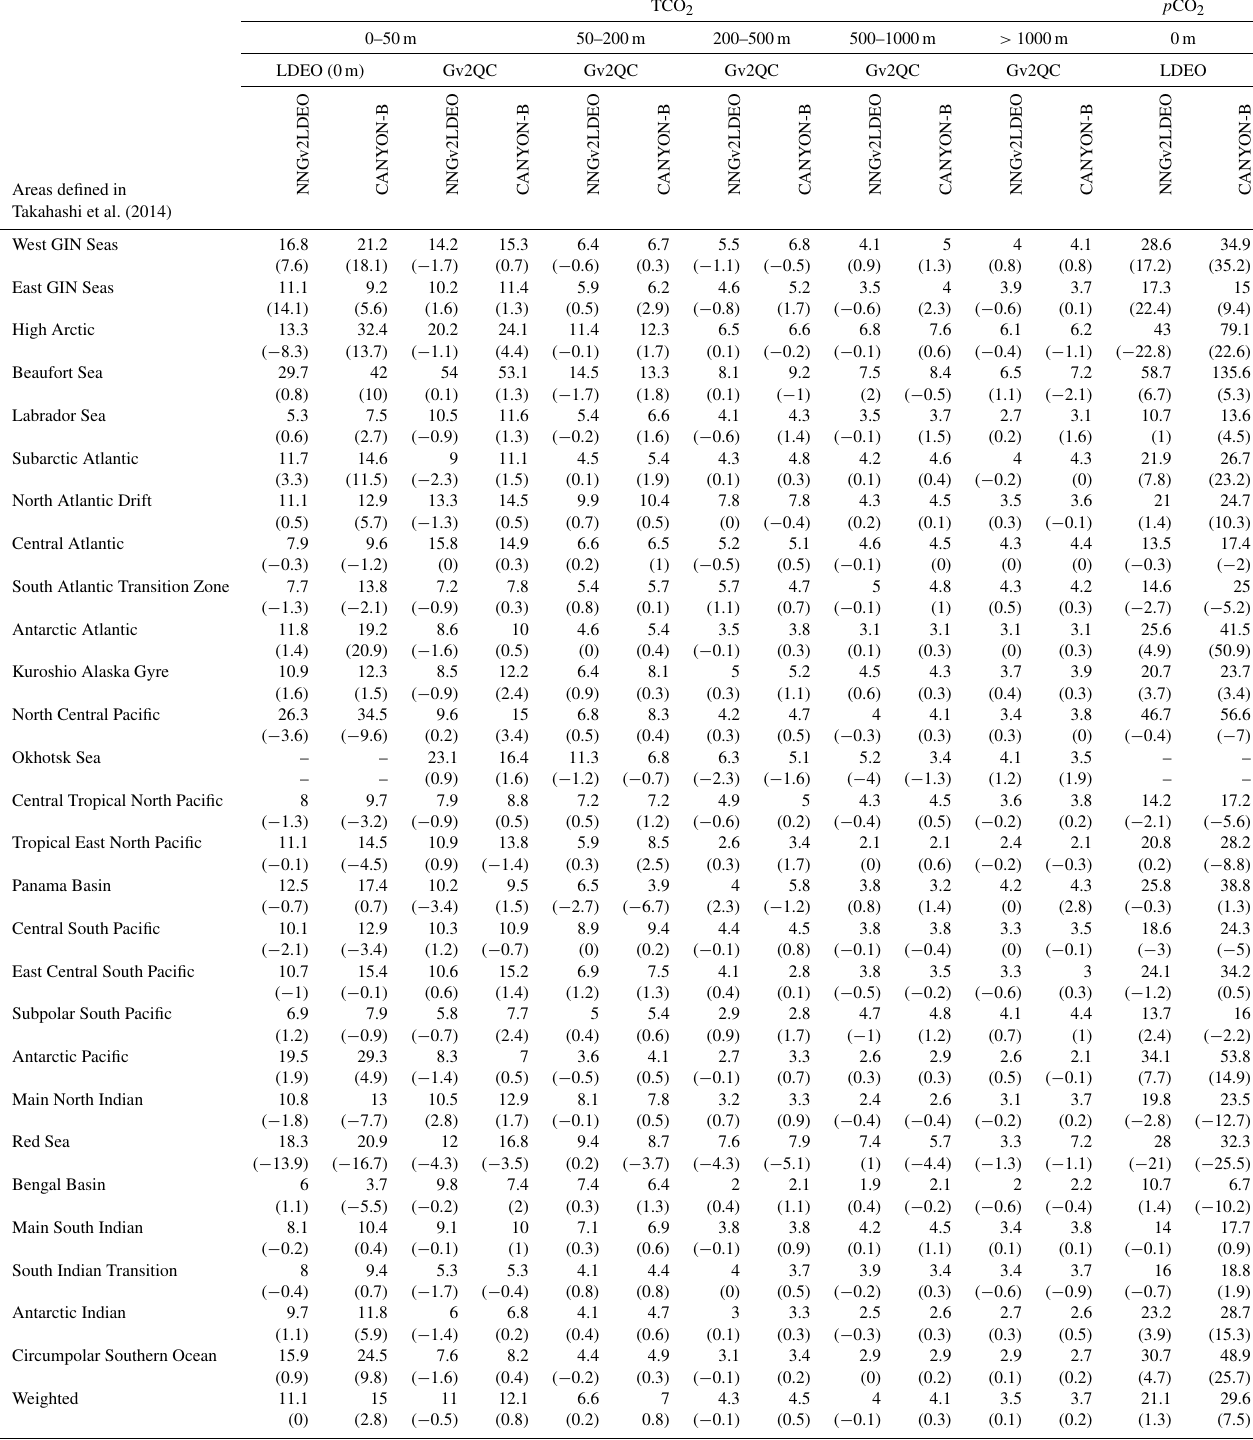
Table 2. RMSE (bias) by area and depth for TCO 2 and p CO 2 , computed with CANYON-B and NNGv2LDEO in Gv2QC and LDEO datasets. For each depth range, the RMSE (bias) in each area was weighted by the contribution of its data to the total. Units are micromoles per kilogram (µmolkg − 1 ) for TCO 2 and microatmospheres (µatm) for p CO 2